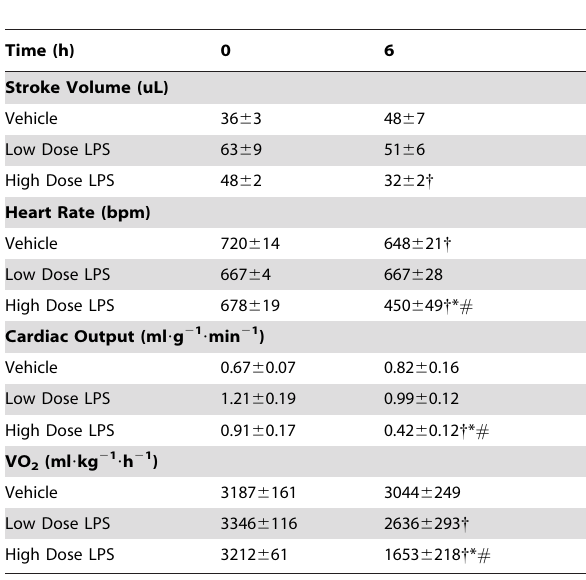
Table 3. Cardiovascular parameters following vehicle or LPS